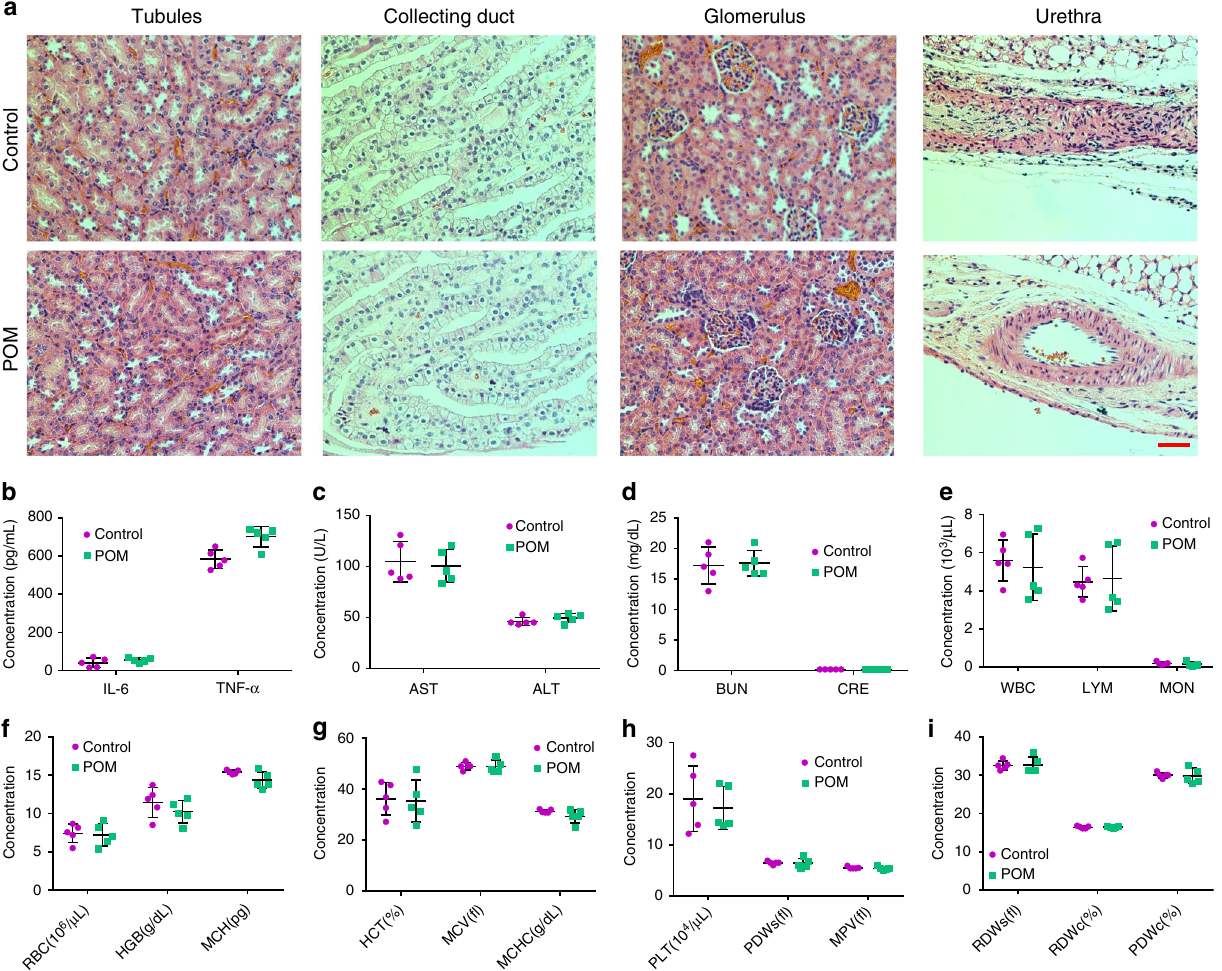
Fig. 7 In vivo toxicity assessment of POM nanoclusters. a H&E-stained tissues from the kidneys. Scale bar: 50 µ m. b Serum levels of interleukin-6 (IL-6) and tumor necrosis factor alpha (TNF- α ) in normal mice (Control group) and mice injected with POM nanoclusters. c Serum levels of liver function indicators of alanine transaminase (ALT) and aspartate transaminase (AST). d kidney function indicators of blood urea nitrogen (BUN) and creatinine (CRE) in normal mice (Control group), and mice injected with POM nanoclusters. e – i Values of blood parameters in normal mice (Control group), and mice injected with POM nanoclusters. In b – i , data represent means ± s.d. from fi ve independent